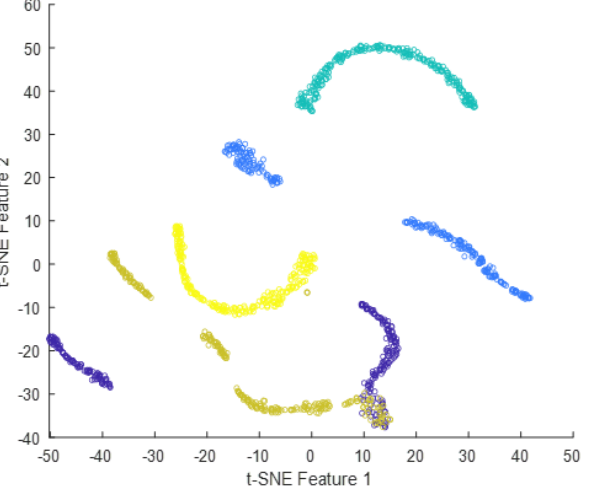
Figure 16. t-SNE plot of the extracted features from the fully-connected layer for dataset#1. Table 11. The best results for pre-trained models with image super-resolution using the three datasets. Dataset